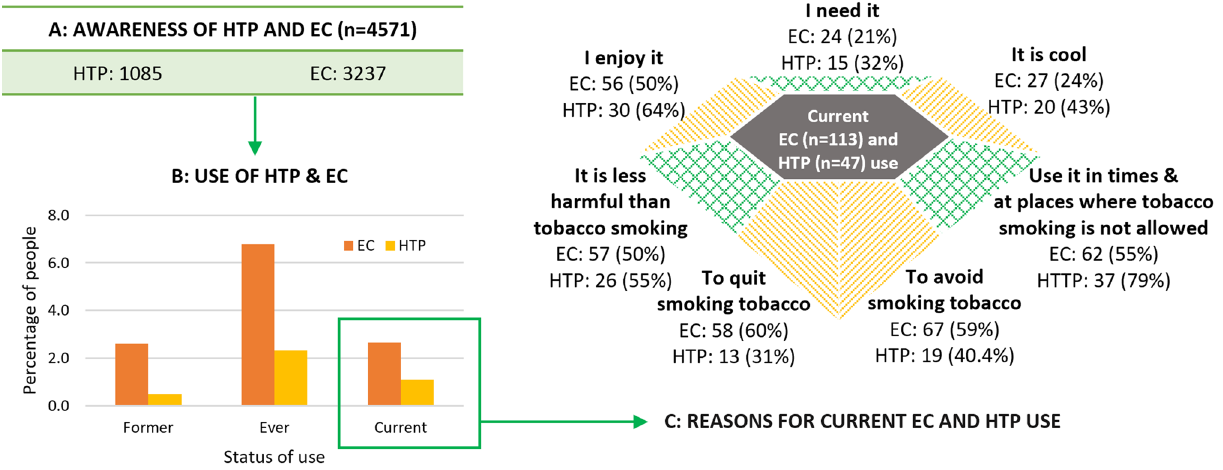
Figure 2. Awareness, current use, and reasons for current use of EC and